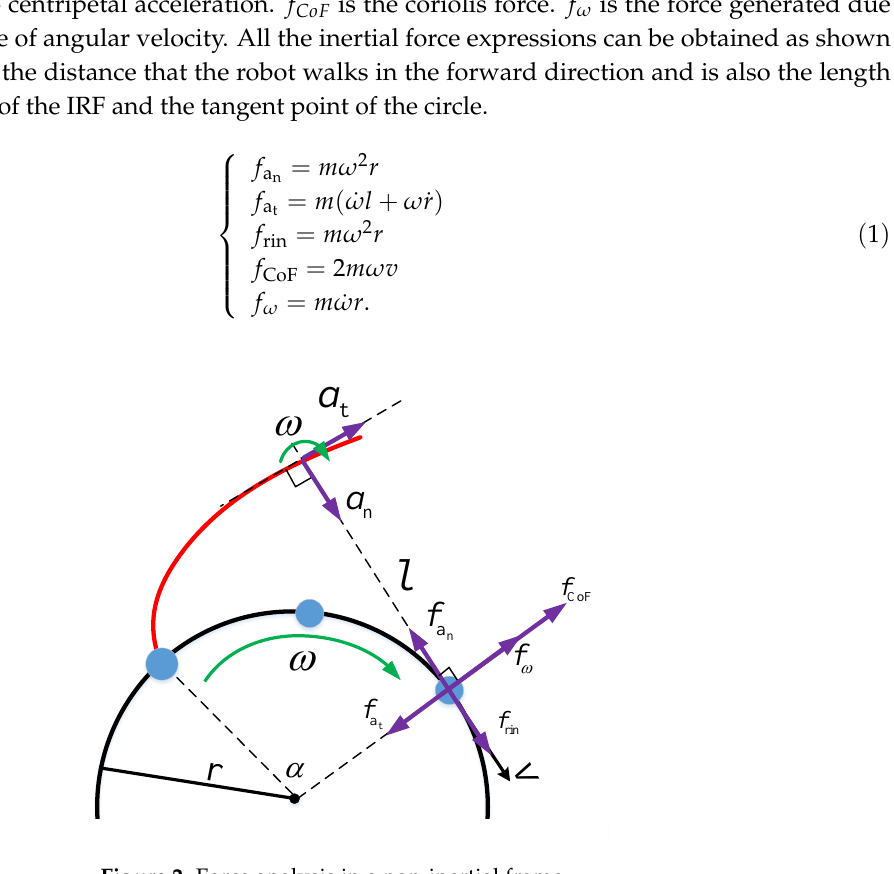
Figure 2. Force analysis in a non-inertial